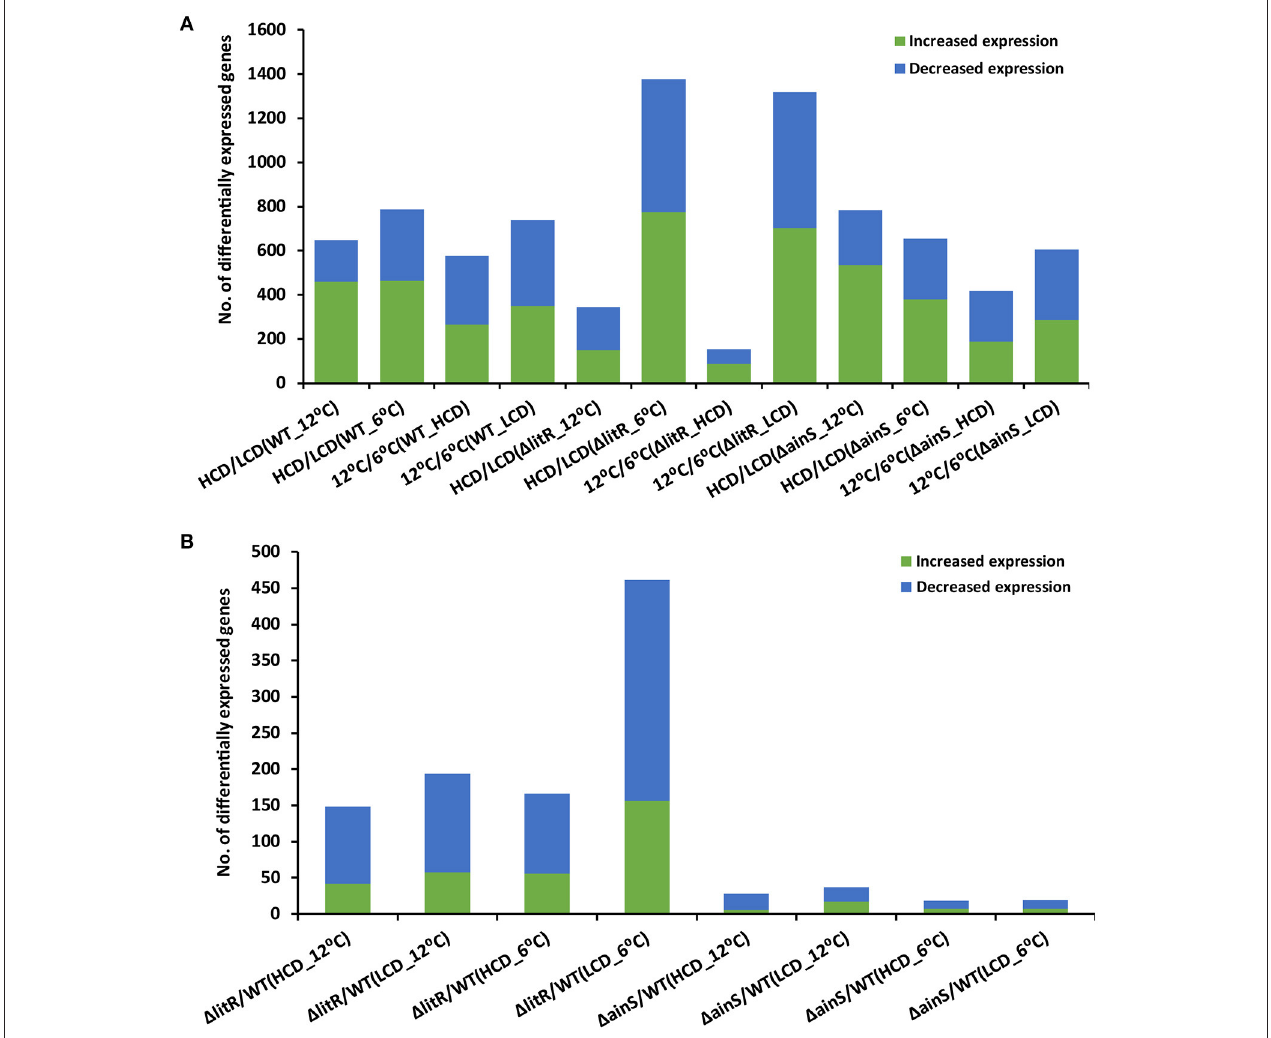
FIGURE 1 | The total number of differentially expressed genes in A. wodanis 06/09/139, 1 ainS and 1 litR . (A) The bar chart shows the number of increased (green) and decreased (blue) expression of genes when comparing high cell density (HCD) to low cell density (LCD) and growth temperature at 12 to 6 ◦ C. (B) The bar chart shows the number of increased and downregulated genes in comparisons 1 litR /WT and 1 ainS